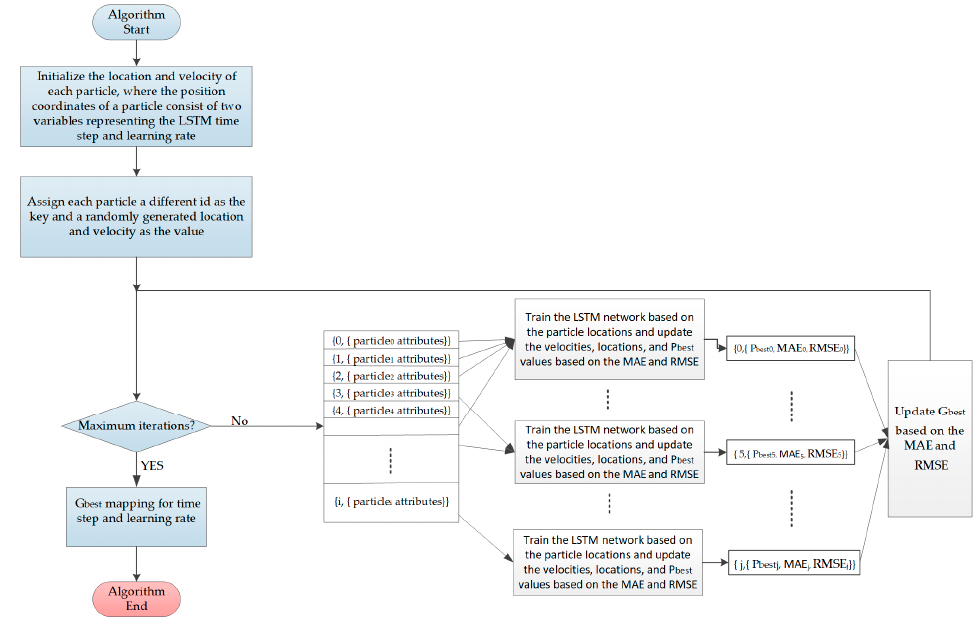
Figure 3. Flowchart of the parallel particle swarm optimization- long short term memory (PSO-LSTM) model for water quality forecasting.